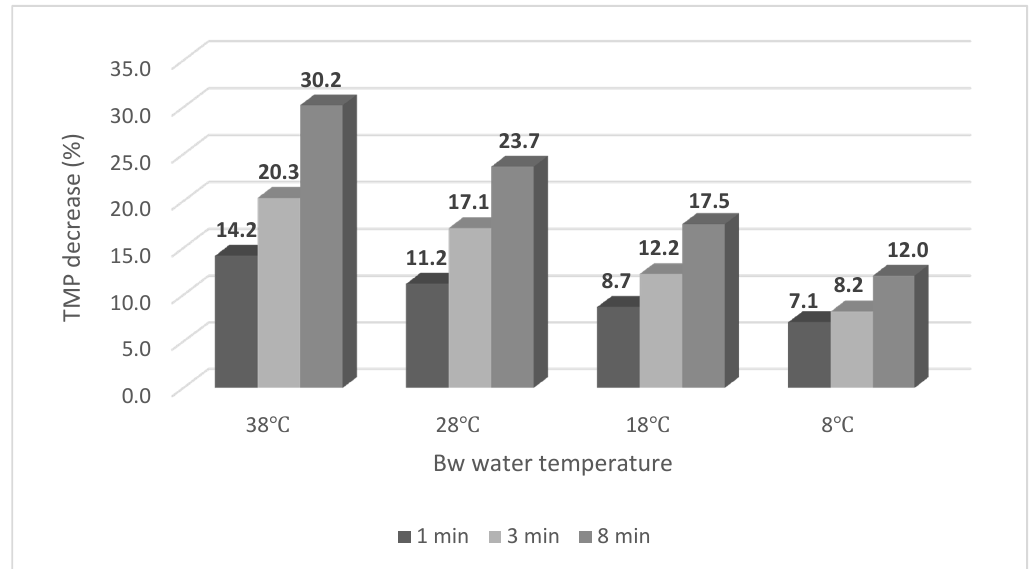
Figure 2. Impact of water temperature on TMP decrease for the BW durations of 1 min, 3 min and 8 min.